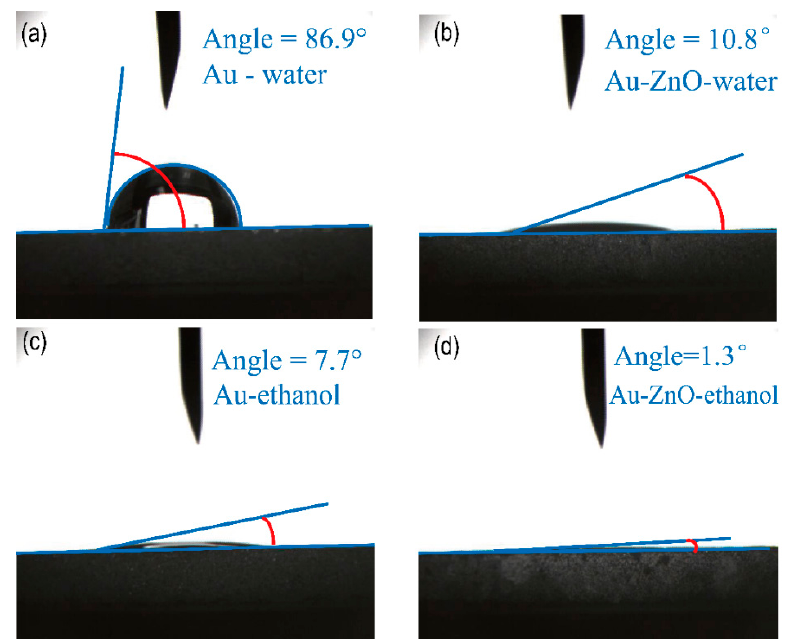
Figure 3. Elemental analysis. ( a ) EDS spectrum of ZnO nanoflowers/Au structure. ( b ) Enlarged view of ZnO nanoflowers/Au structure. ( c ) Elemental mapping of ZnO nanoflowers/Au structure: Zn, O ( d ) and Au ( e ).